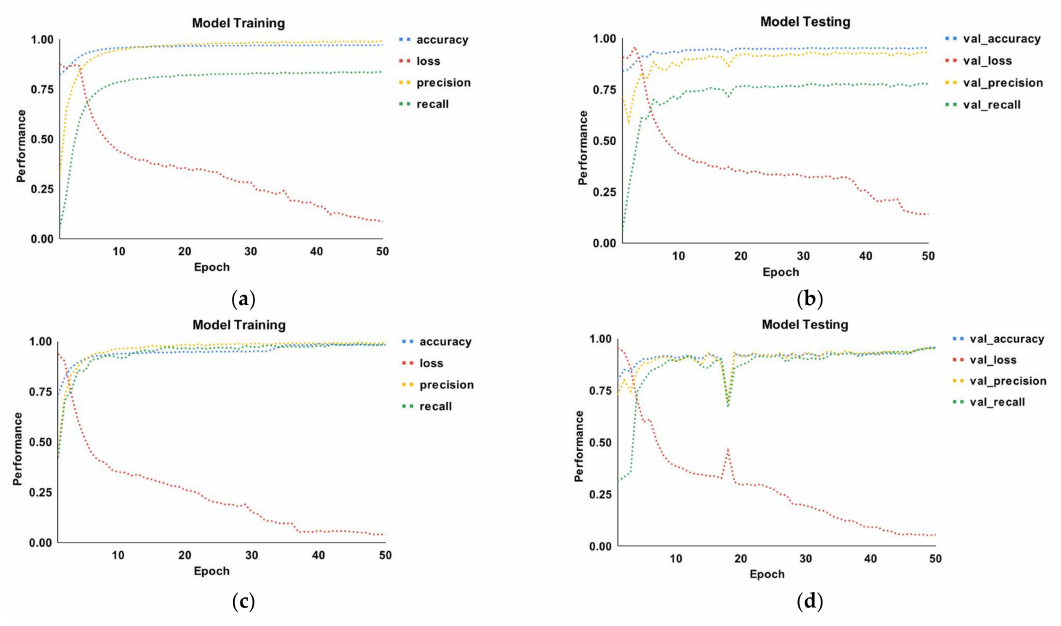
Figure 8. Dynamic epoch curves (accuracy, precision, recall, loss) for malware detection using training and testing data: ( a ) dataset 1 (training); ( b ) dataset 1 (testing); ( c ) dataset 2 (training); ( d ) dataset 2